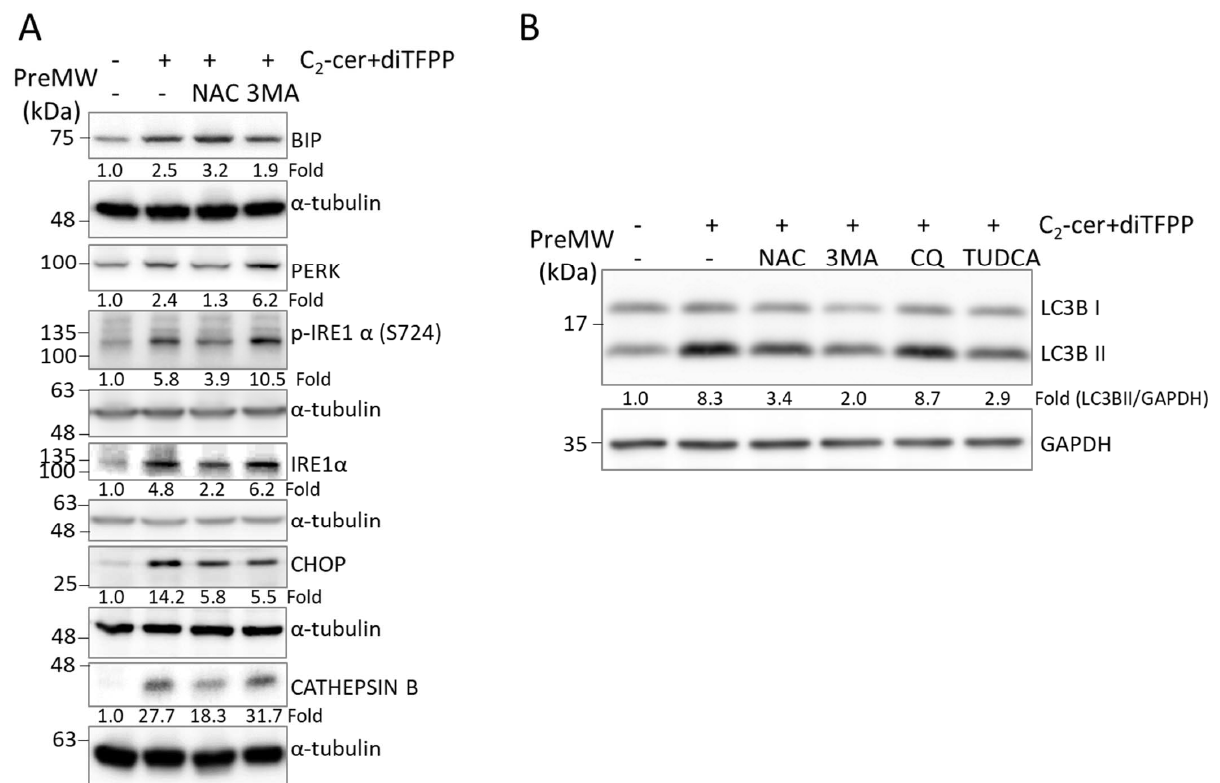
Figure 6. Roles of ER stress and autophagy activation in HCC cells following C 2 -ceramide/diTFPP cotreatment. To validate the roles of ROS production, ER stress and autophagy initiated in HCC cells cotreated with ceramide and diTFPP, HCC cells were pretreated with the ROS scavenger NAC (10 mM), autophagy inhibitors 3-MA (2 mM) and CQ (20 μM), and ER stress inhibitor TUDCA (100 μM) for 6 h and with 10 μM diTFPP and 20 μM C2-ceramide for 24 h. ( A ) Assessment of ER stress-associated proteins and CATHEPSIN B. ( B ) Assessment of the autophagy indicator LC3B II. α-Tubulin and GAPDH were used as the internal controls. PreMW: prestained protein marker (see Section 2.4).